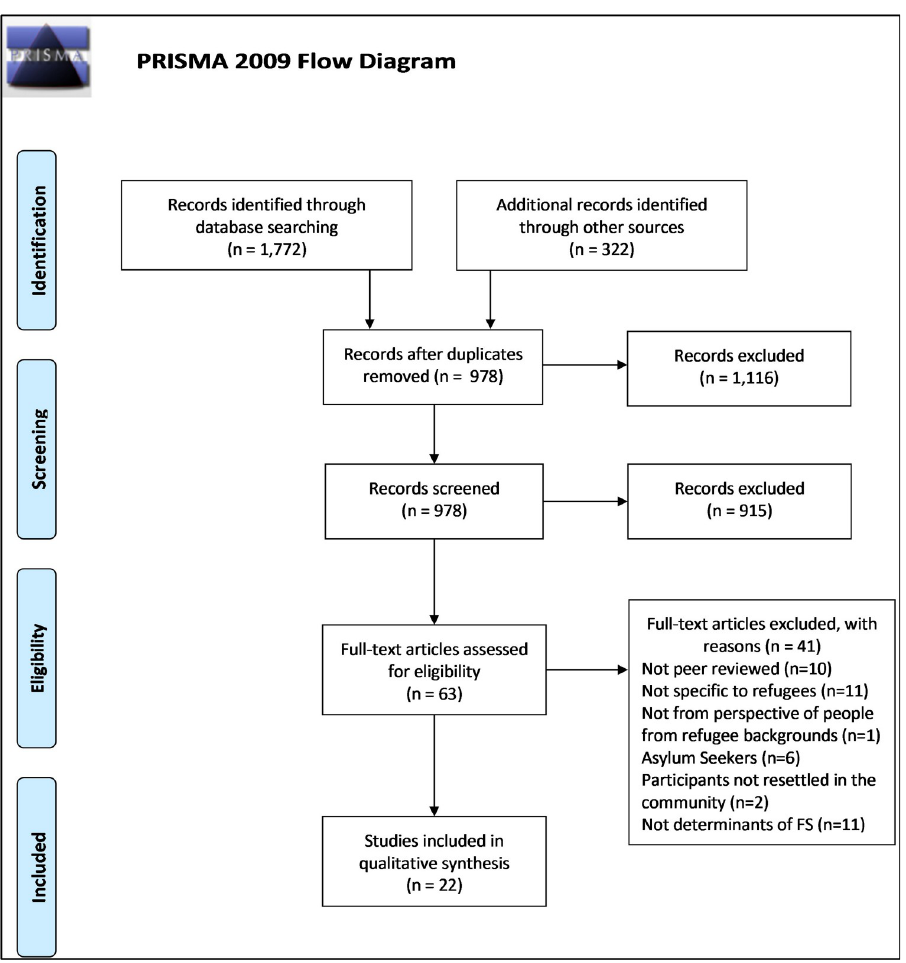
Fig 1. PRISMA 2009 flow diagram of article